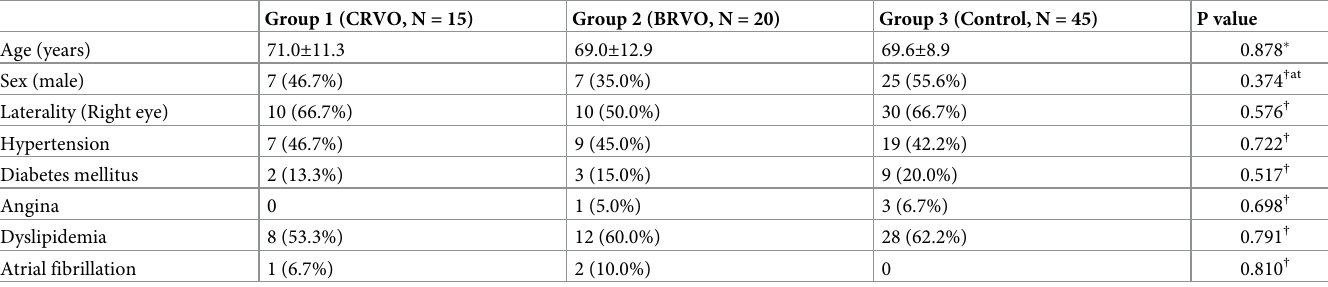
Table 1. Baseline characteristics of study population at the time of